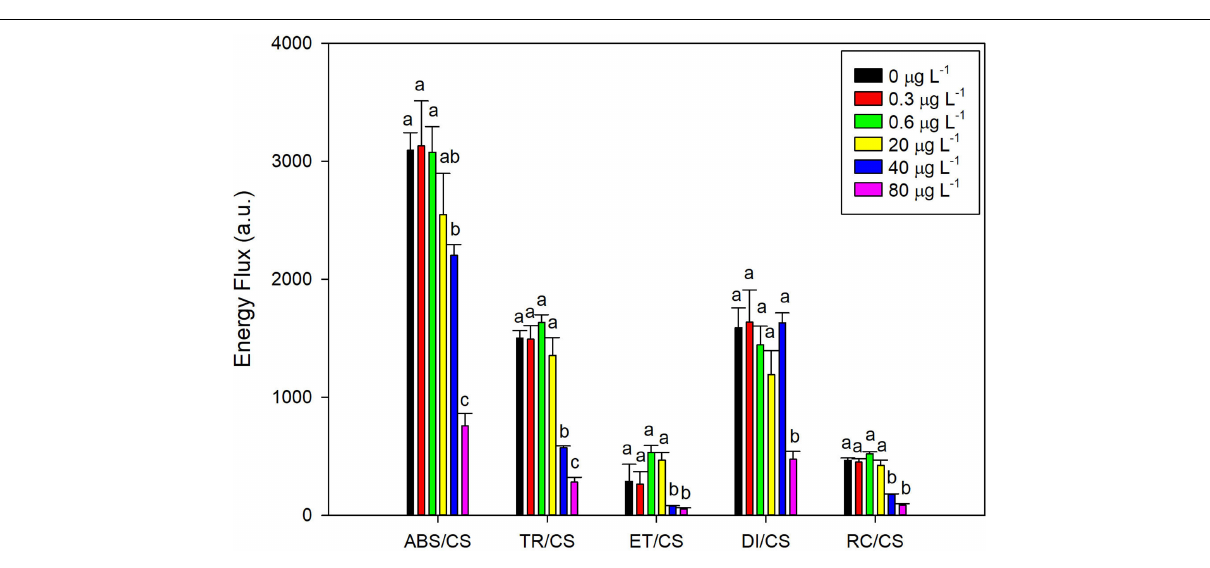
FIGURE 2 | Phaeodactylum tricornutum phenomenological energy fluxes: absorbed (ABS/CS), trapped (TR/CS), transported (ET/CS), dissipated (DI/CS) and number of available reaction centers per cross section (RC/CS), following a 48 h exposure to different fluoxetine concentrations. Average ± standard deviation, N = 3, different letters indicate significant differences at p <